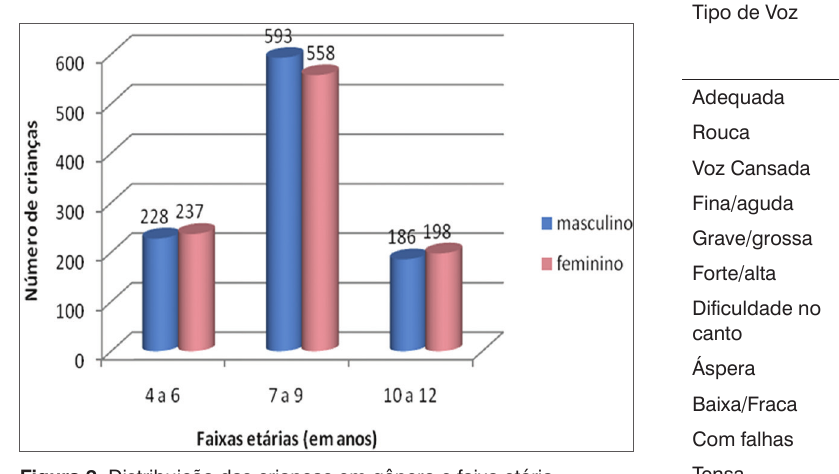
Figura 2. Distribuição das crianças em gênero e faixa